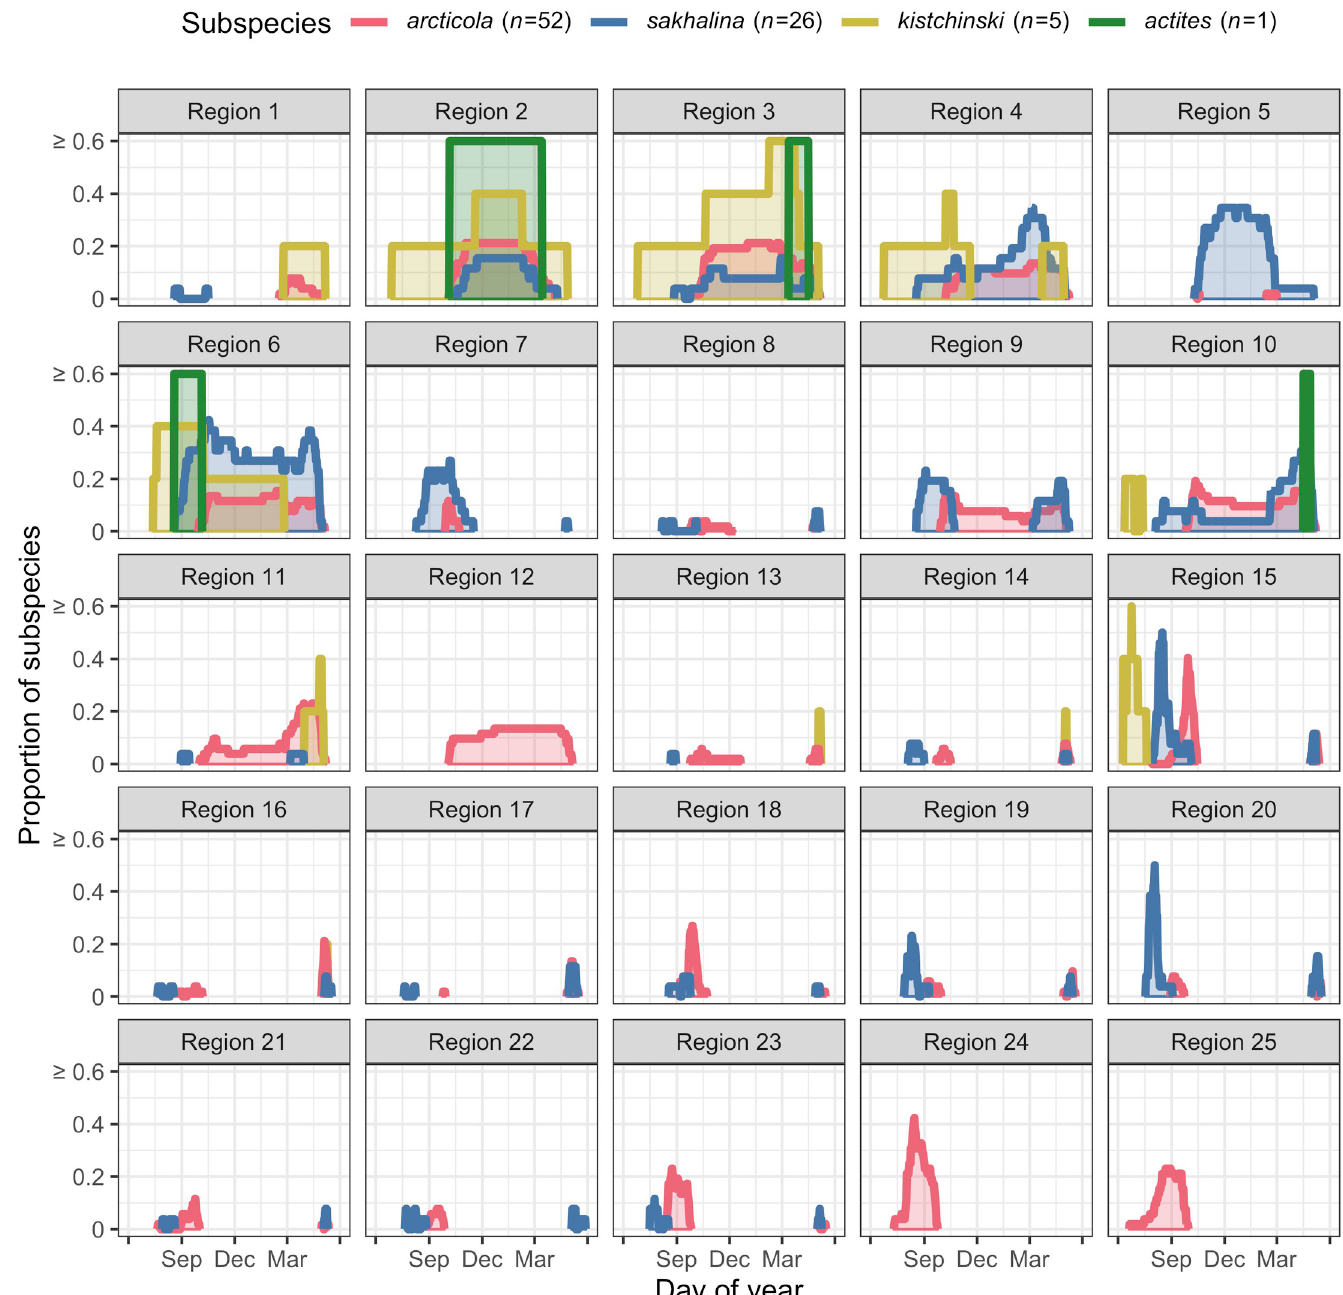
Fig 3. The proportion of each Dunlin subspecies that occurred in each flyway region along the East Asian-Australasian Flyway by day of year. See Fig 2 for the location of each region.